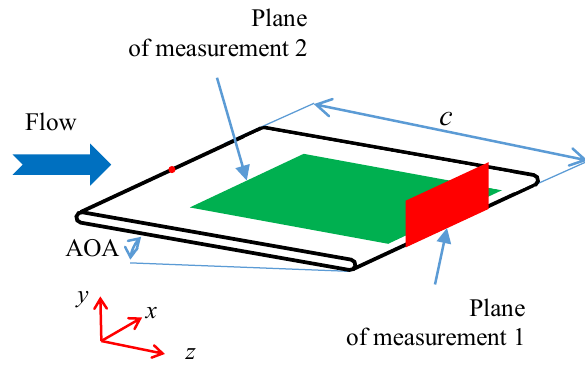
Fig. 1. Schematics of the experiment